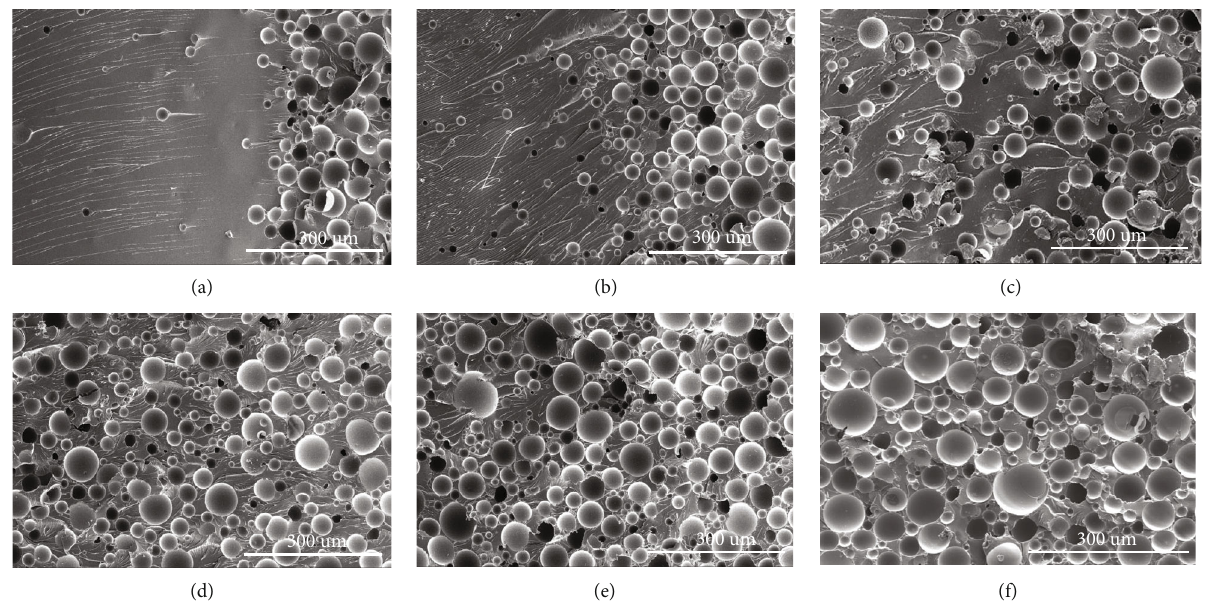
Figure 5: HGM/EP composite insulation materials with di ff erent HGM volume fractions: (a) 10%, (b) 20%, (c) 30%, (d) 40%, (e) 50%, and (f) 60%.